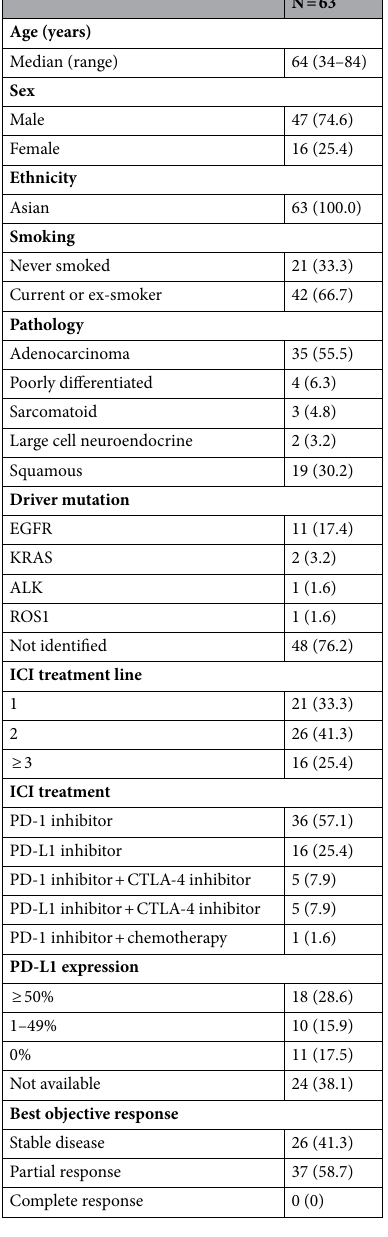
Table 1. Patient characteristics. EGFR epidermal growth factor receptor, ALK anaplastic lymphoma kinase, PD-1 programmed death 1, PD-L1 programmed death ligand 1, CTLA-4 Cytotoxic T-Lymphocyte Associated Protein 4. *Data are presented as the median (range) or number